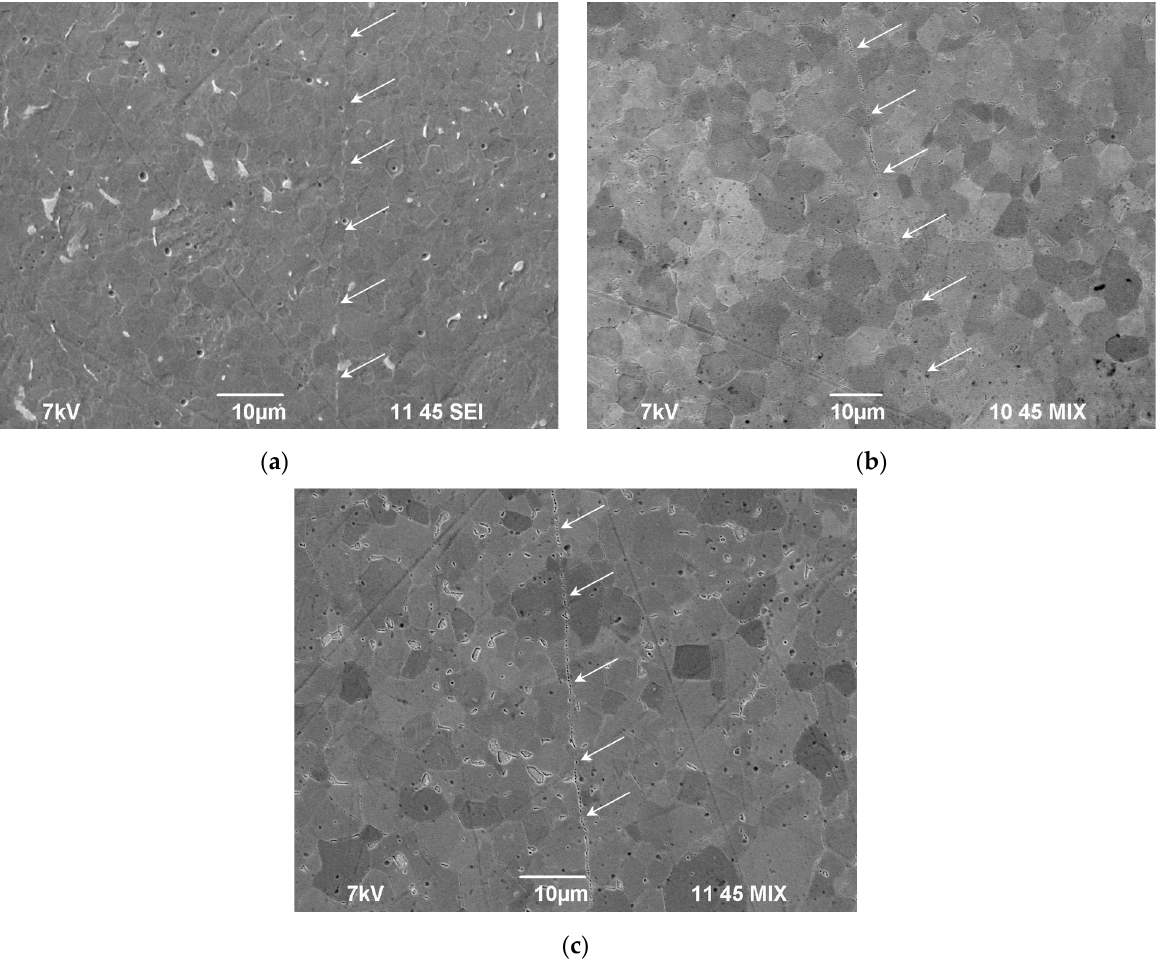
Figure 7. Micropores in the welded joints of the UFG titanium alloy after diffusion welding (t = 10 min, P = 50 MPa): ( a ) V h = 50 °C/min, T = 600 °C; ( b ) V h = 350 °C/min, T = 700 °C; ( c ) V h = 50 °C/min, T = 800 °C. SEM.